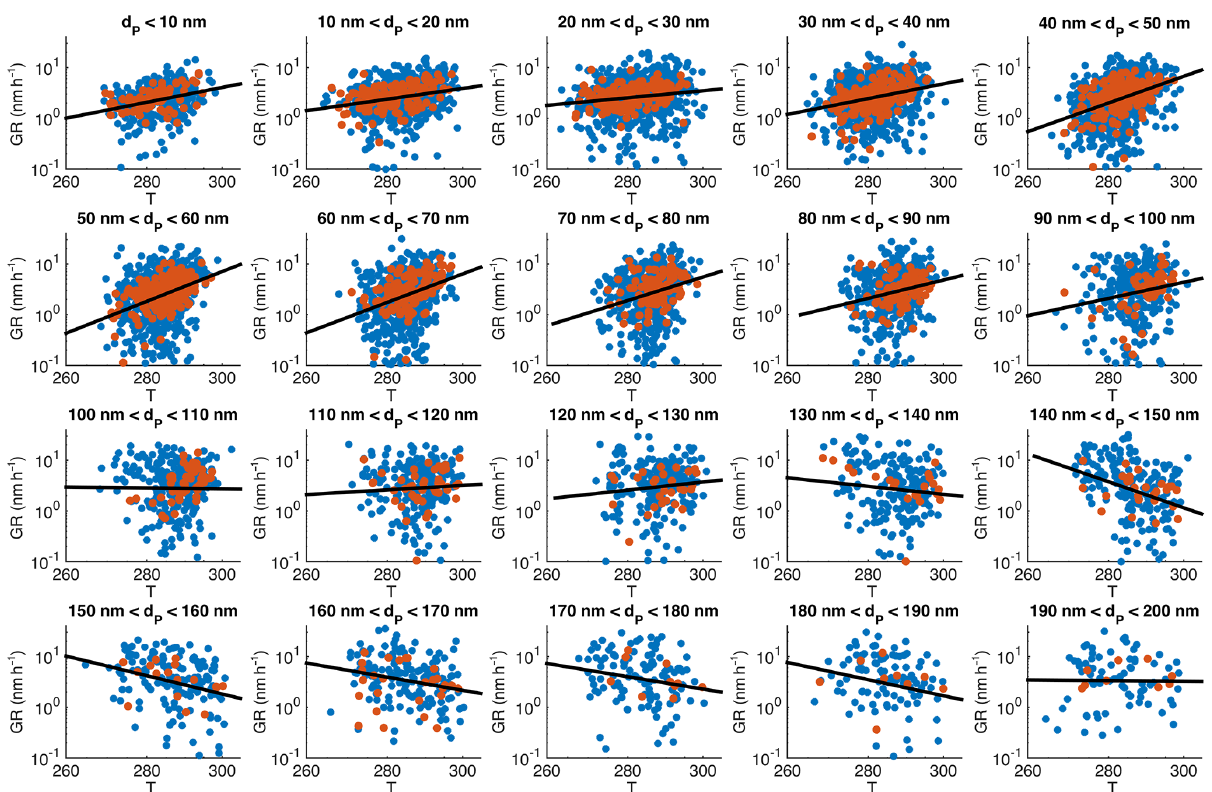
Figure 5. Particle growth rate as a function of mean temperature during the growth period, binned with respect to the start size of the observed growth. The blue points depict all the determined growth periods, red ones the long (>5h) growth periods and the black lines are log-linear least-squares fittings for all the growth periods (blue points).